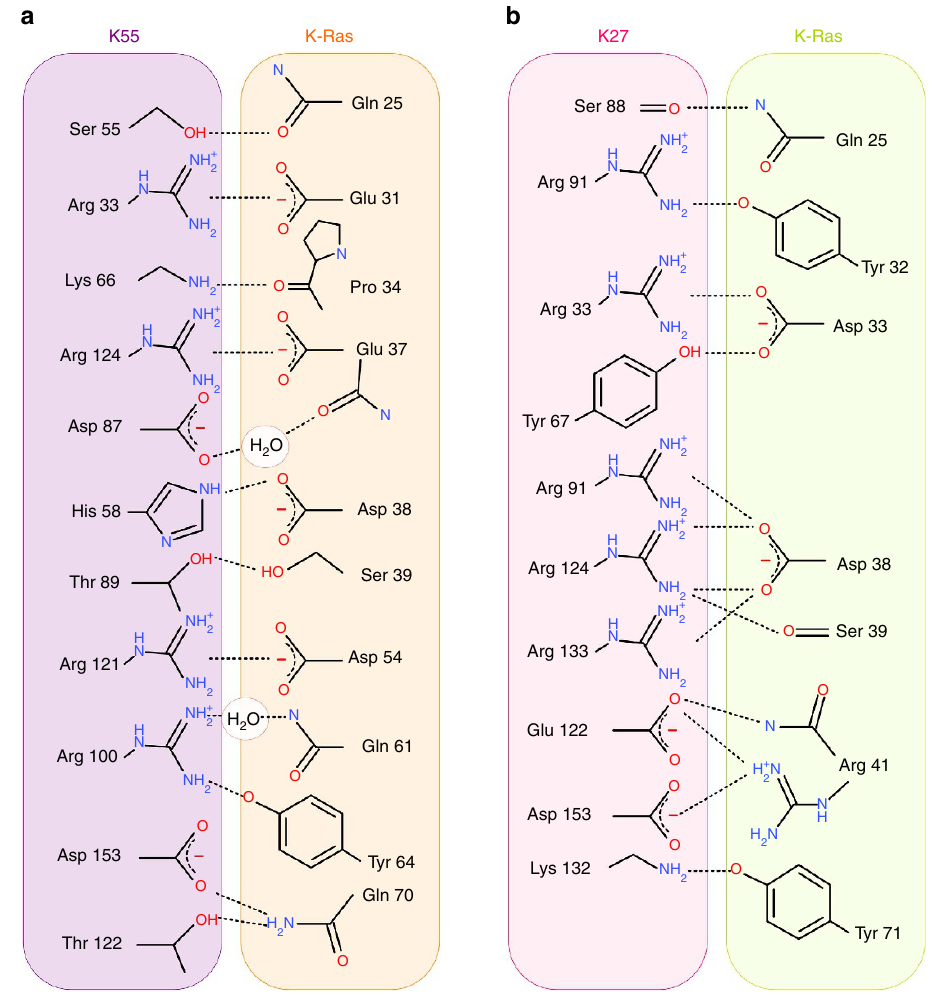
Figure 4 | Comparative interaction summaries for K27 and K55 complexes with Ras. Direct residue interactions in the two DARPin/Ras complexes are summarized for the comparison of DARPin K55/Ras ( a ) with K27/Ras ( b ). While some Ras residues participate in both DARPin interactions, namely Gln 25, Asp 38 and Ser 39, most of the participating Ras residues are unique to either the K55 or K27 interaction, suggesting very different overall binding modes in each